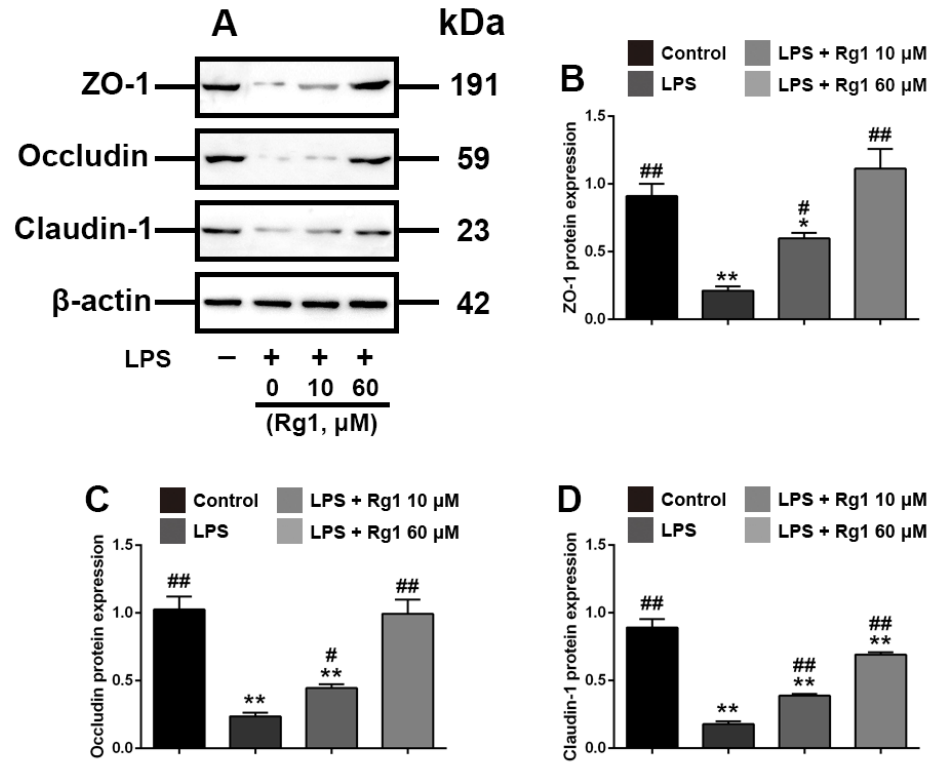
Figure 2. Rg1 inhibits LPS-induced tight junction disruption in IPEC-J2 cells in vitro. IPEC-J2 cells were treated with vehicle, Rg1 or LPS at the indicated concentrations for 48 h. ( A ) Western blot analyses of tight-junction-related proteins; effect of Rg1 on ZO-1 ( B ), occludin ( C ) and claudin-1 ( D ) in IPEC-J2 cells. β -Actin was used as an invariant control for equal loading. Blots are representative of three independent experiments with densitometry, showing the mean ± s.d. * p < 0.05 versus control and ** p < 0.01 versus control. # p < 0.05 versus LPS and ## p < 0.01 versus LPS.